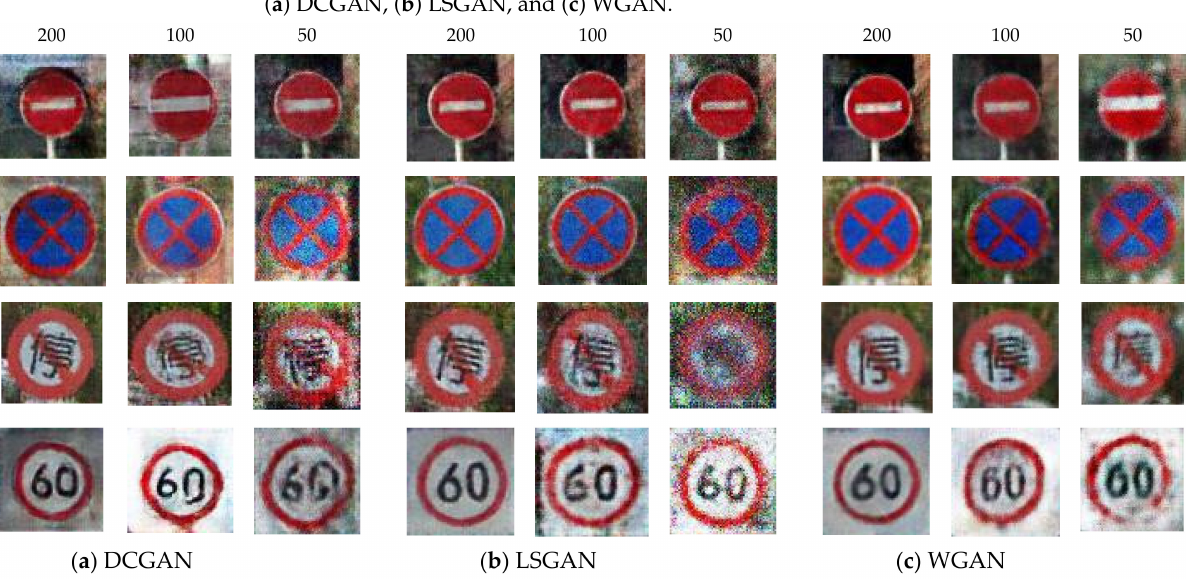
Figure 8. Synthetic traffic sign images of all classes with epoch 1000 and size 64 × 64 generated by ( a ) DCGAN, ( b ) LSGAN, and ( c ) WGAN.